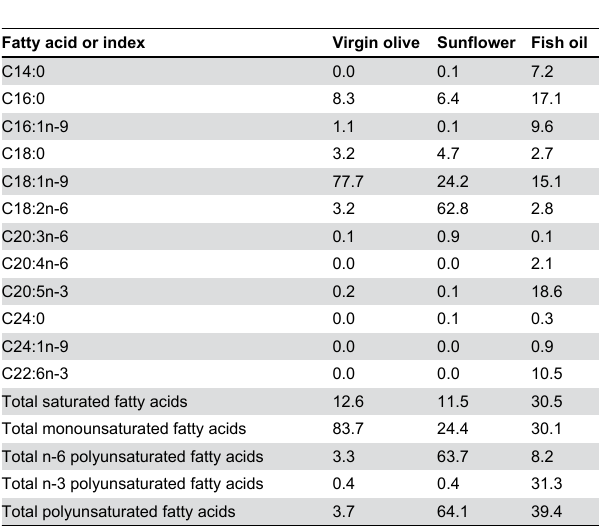
Table 1. Fatty acids profile of experimental dietary fats (g/